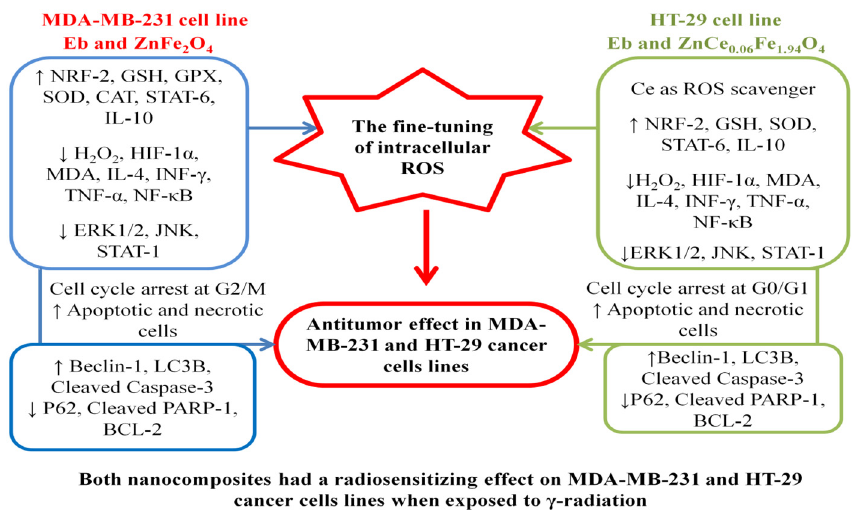
Figure 21. Signalling pathways involved in the antitumour activity of Eb + ZnFe 2 O 4 and ZnCe x Fe 2 − x O 4 ; X = 0.06 nanocomposites, where the effect is mediated through the